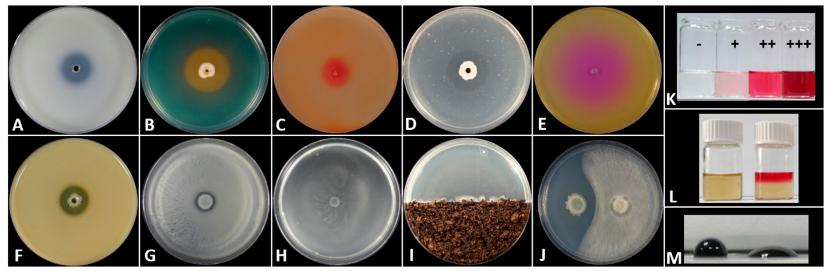
Figure 2. PGP traits, motility and biocontrol ability in vitro of bacterial endophytes of C. officinalis . ( A ) Phosphate solubilization (clear halo), ( B ) Siderophore production (yellow-orange halo), ( C ) Cellu- lase production (red halo), ( D ) Chitinase production (clear halo), ( E ) Urease production (pink halo), ( F ) Protease production (clear halo), ( G ) Swarming motility, ( H ) Swimming motility, ( I ) Chemotaxis, ( J ) Biocontrol of F. oxysporum (inhibition zone), ( K ) Indole-3-acetic acid (IAA) production ( − : negative control, +: low production, ++: medium production, +++: high production), ( L ) Acetoin production (left: negative control, right: positive reaction) and ( M ) Drop collapse assay (left: negative control, right: positive reaction).